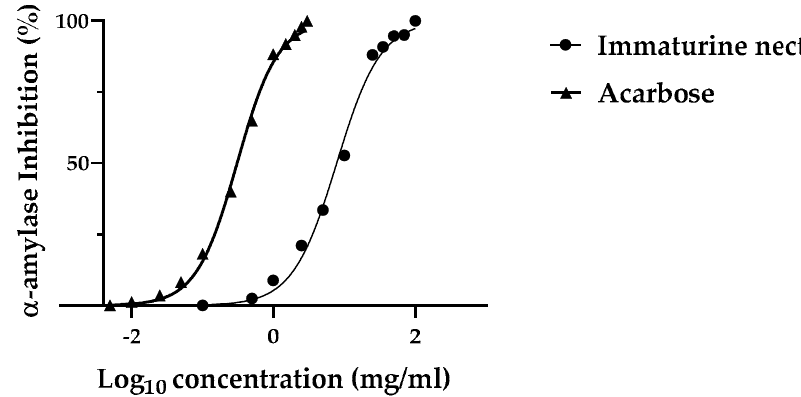
Figure 2. Inhibition of a-amylase activity (%) by Thinned Nectarine and acarbose. Values represent mean ± standard deviation of triplicate readings.